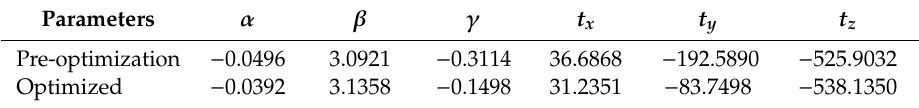
Table 4. Extrinsic parameters between two cameras before and after